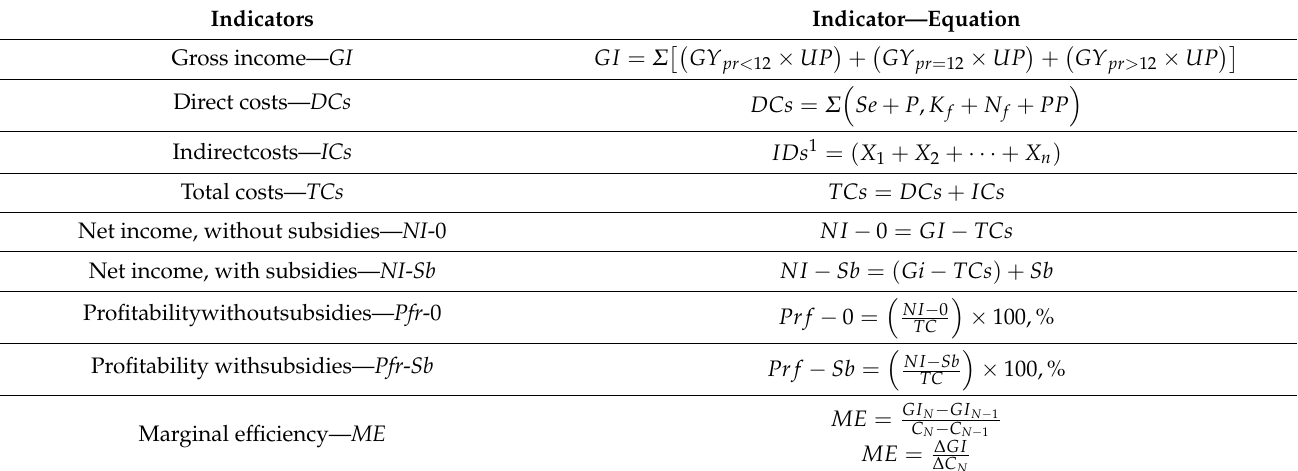
Table 1. Economic indicators of wheat